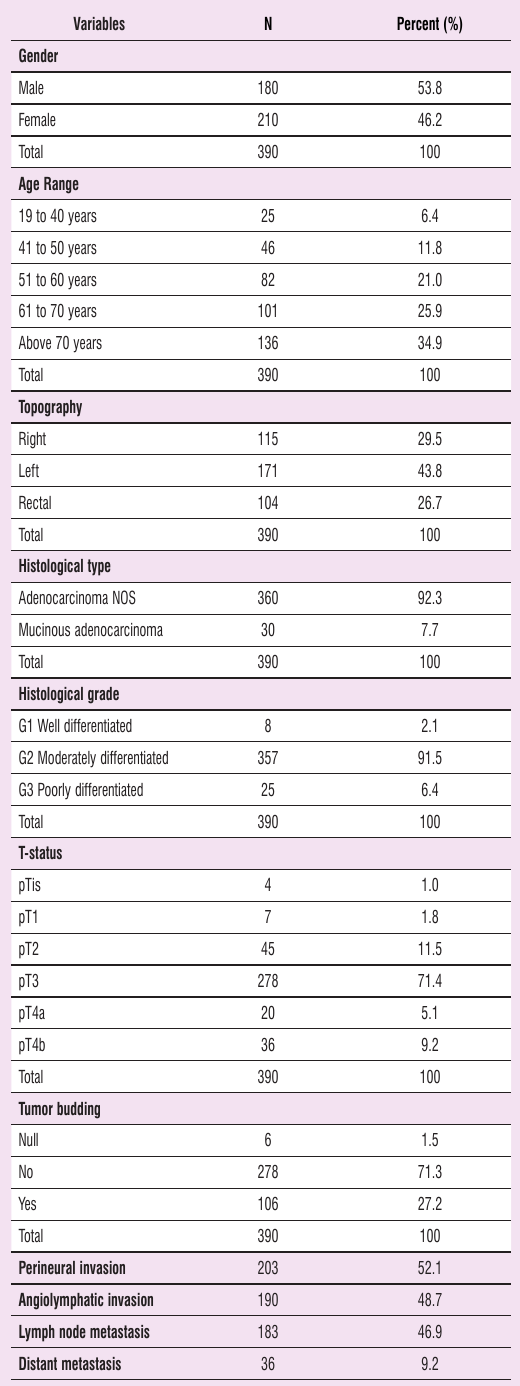
Table 1: Absolute and relative frequency of clinico-pathological characteristics